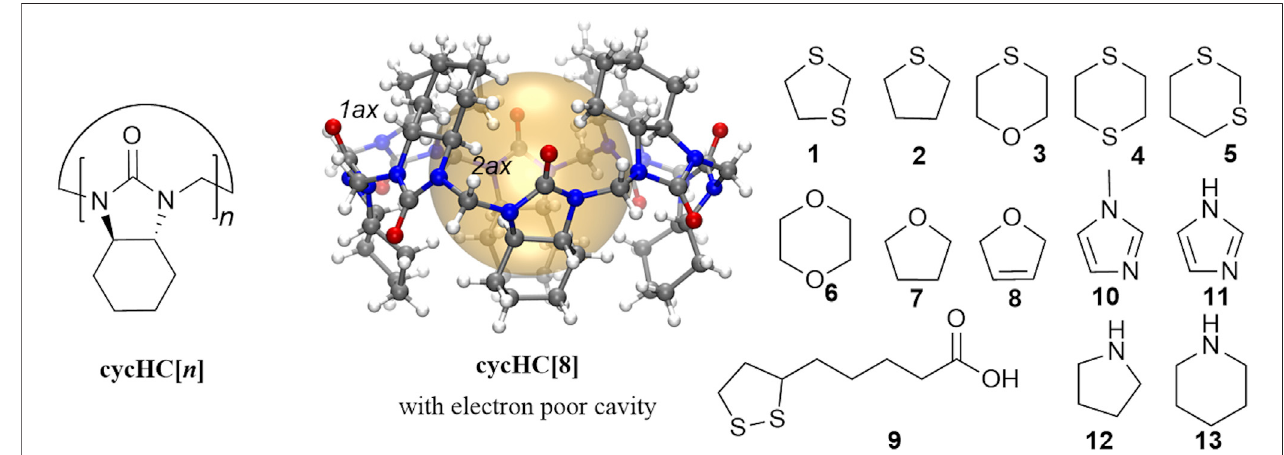
FIGURE1| StructureofcycHC[ n ]andcycHC[8],highlightingtheelectron-poorcavityforguestbindingandcharacteristicatomnumbers,andthescopeofstudied guests.